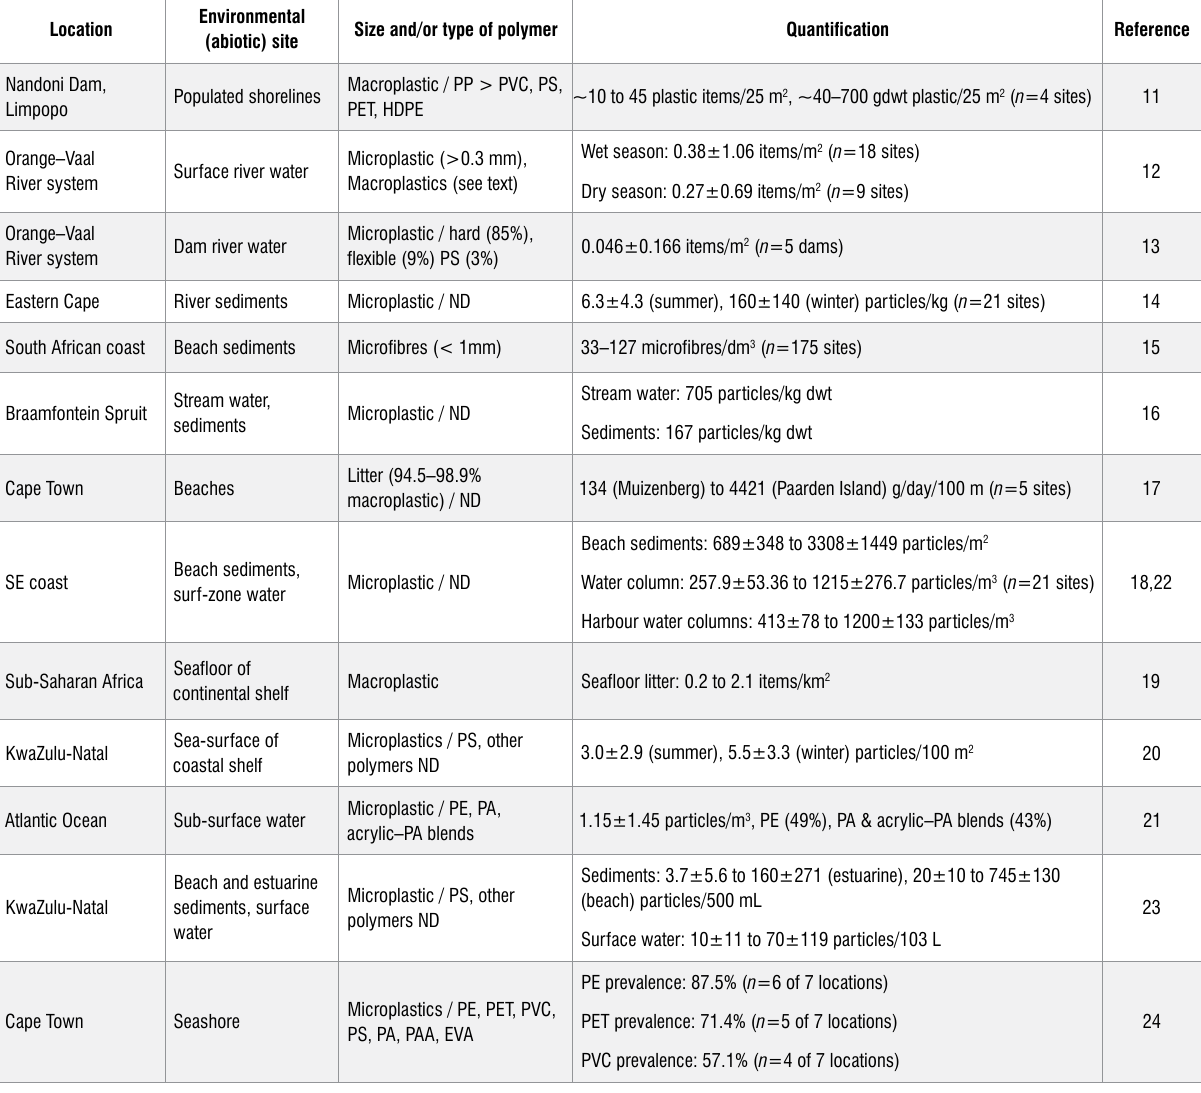
Table 2: Selected data from studies conducted to determine plastic pollution in South Africa and the surrounding marine environment